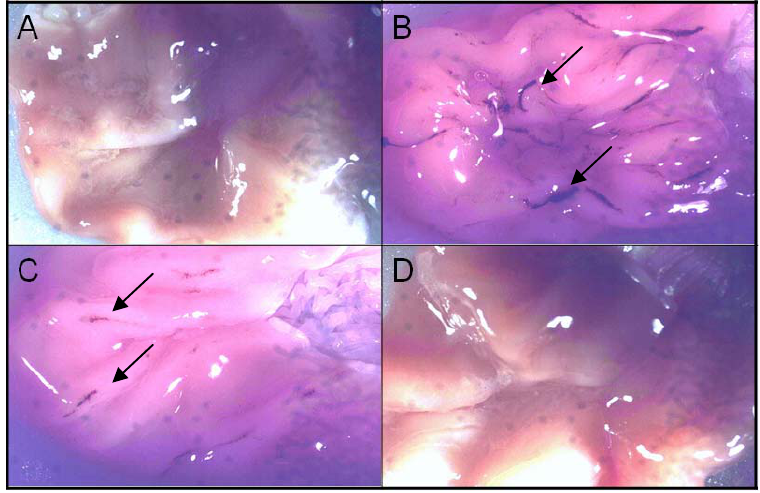
Figure 5 . Stomach ulcerogenicity of compounds at 100 μ mol Kg -1 in rats. A) DMSO control; B) diclofenac (score 4; lesions > 2 mm pointed by arrows); C) celecoxib (score 2; lesions between 1–2 mm pointed by arrows) and; D) lactam derivative ( 1 ) absence of